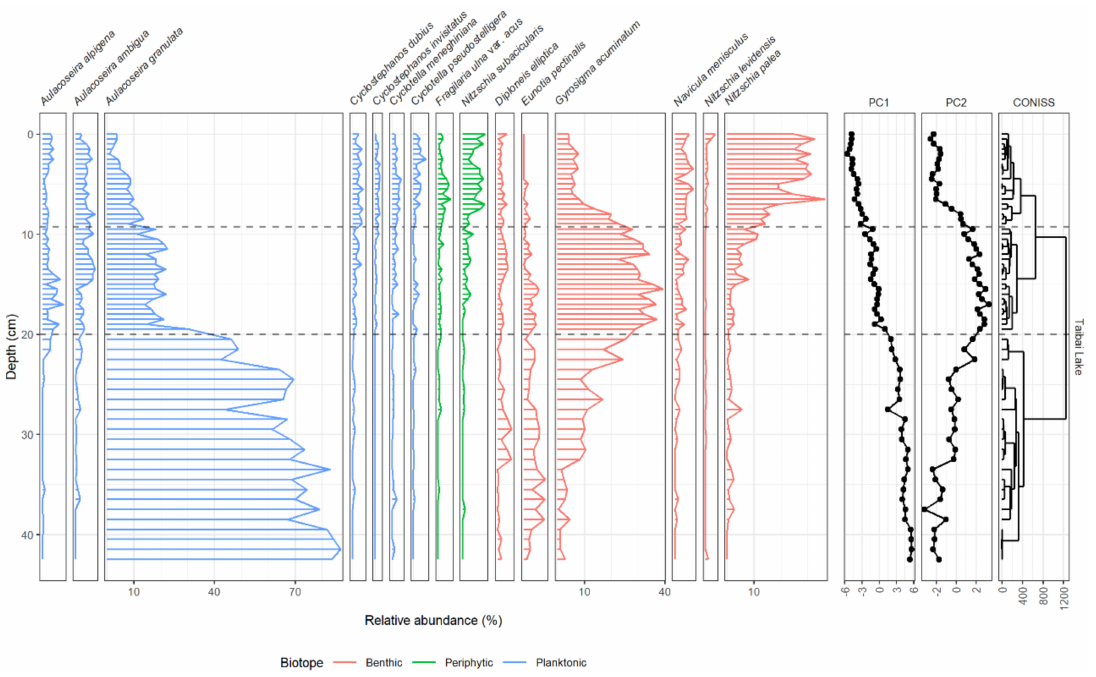
Figure 3. A stratigraphic diagram of the diatom assemblages for TN2007, with the first two axes of PCA and zonations of the broken-stick